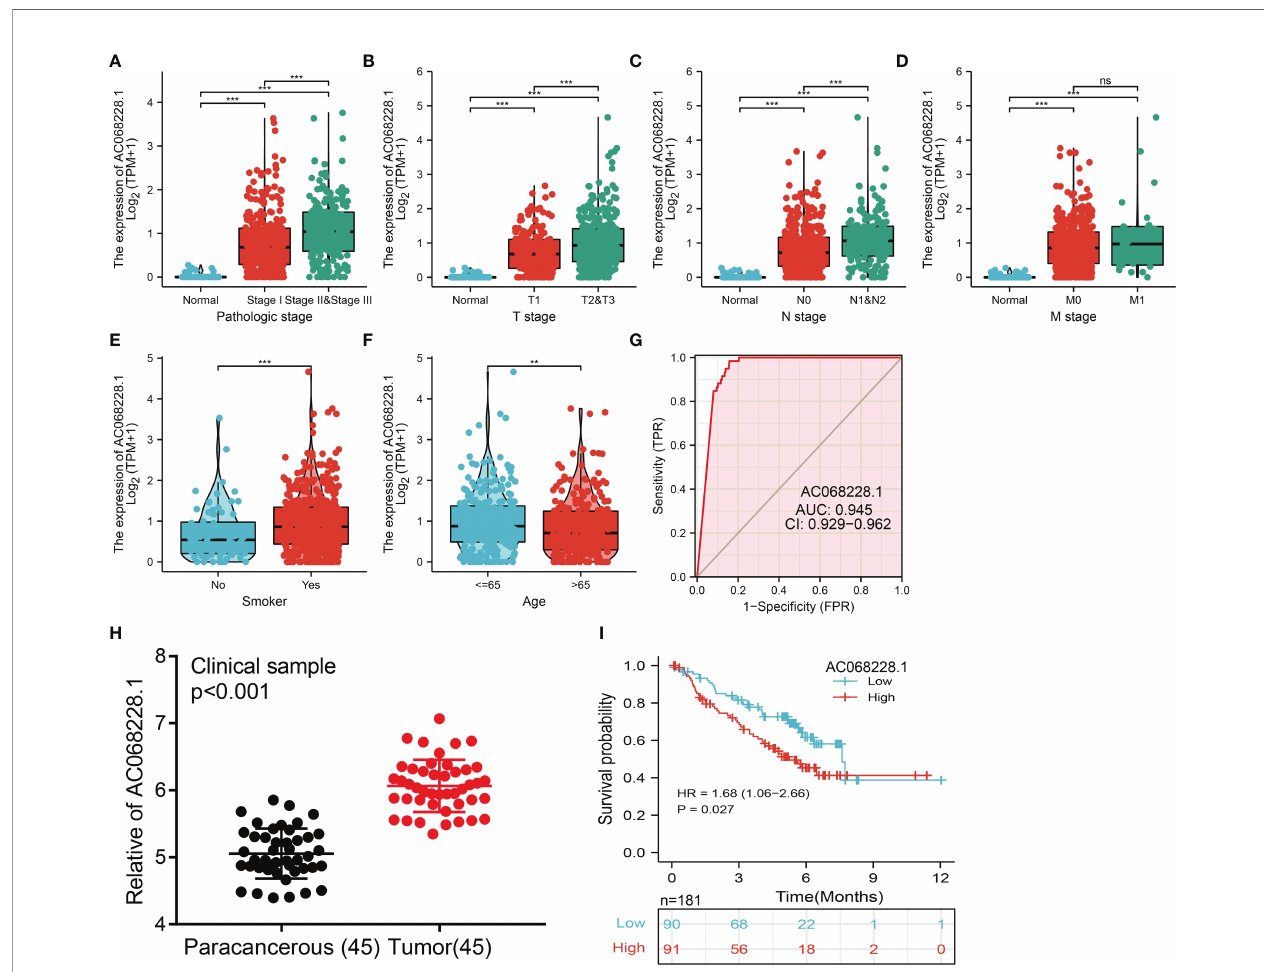
FIGURE 2 | Clinical signi fi cance of lncRNA-AC068228.1 in lung adenocarcinoma. (A – F) Correlation between AC068228.1 expression and clinical parameters include pathological, TNM stages, smoker, and age. (G) ROC curves were used to determine the diagnostic value of AC068228.1 in lung adenocarcinoma based on TCGA-LUAD. (H, I) The expression level and prognostic value of AC068228.1 in LUAD validation by our clinical samples NS: P > 0.05, **p<0.01,